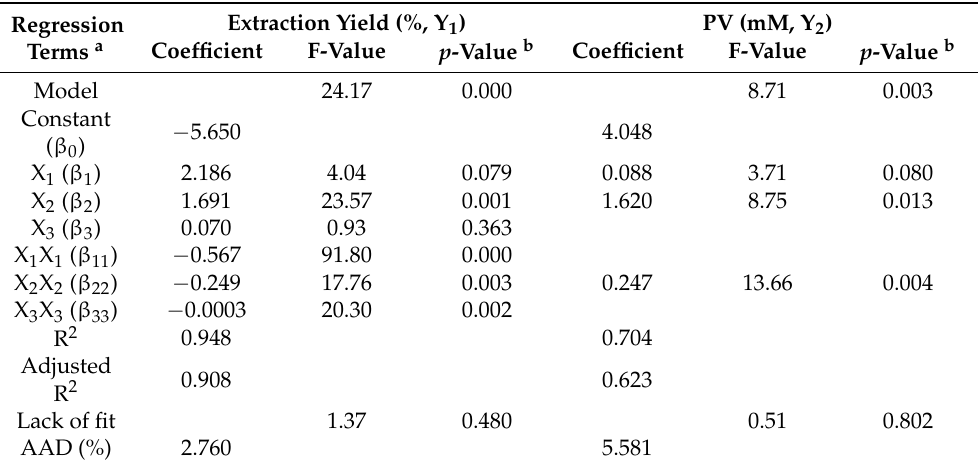
Table 3. The estimated coefficient of the independent variables with the associated statistical signifi- cance of each coefficient for backward regression